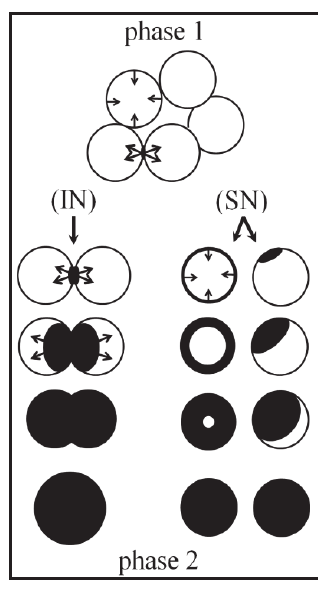
Fig. 1 – Diagram showing nucleation models in the solid- Fig. 1 Diagram showing nucleation models in the solid-phase transformation phase transformation